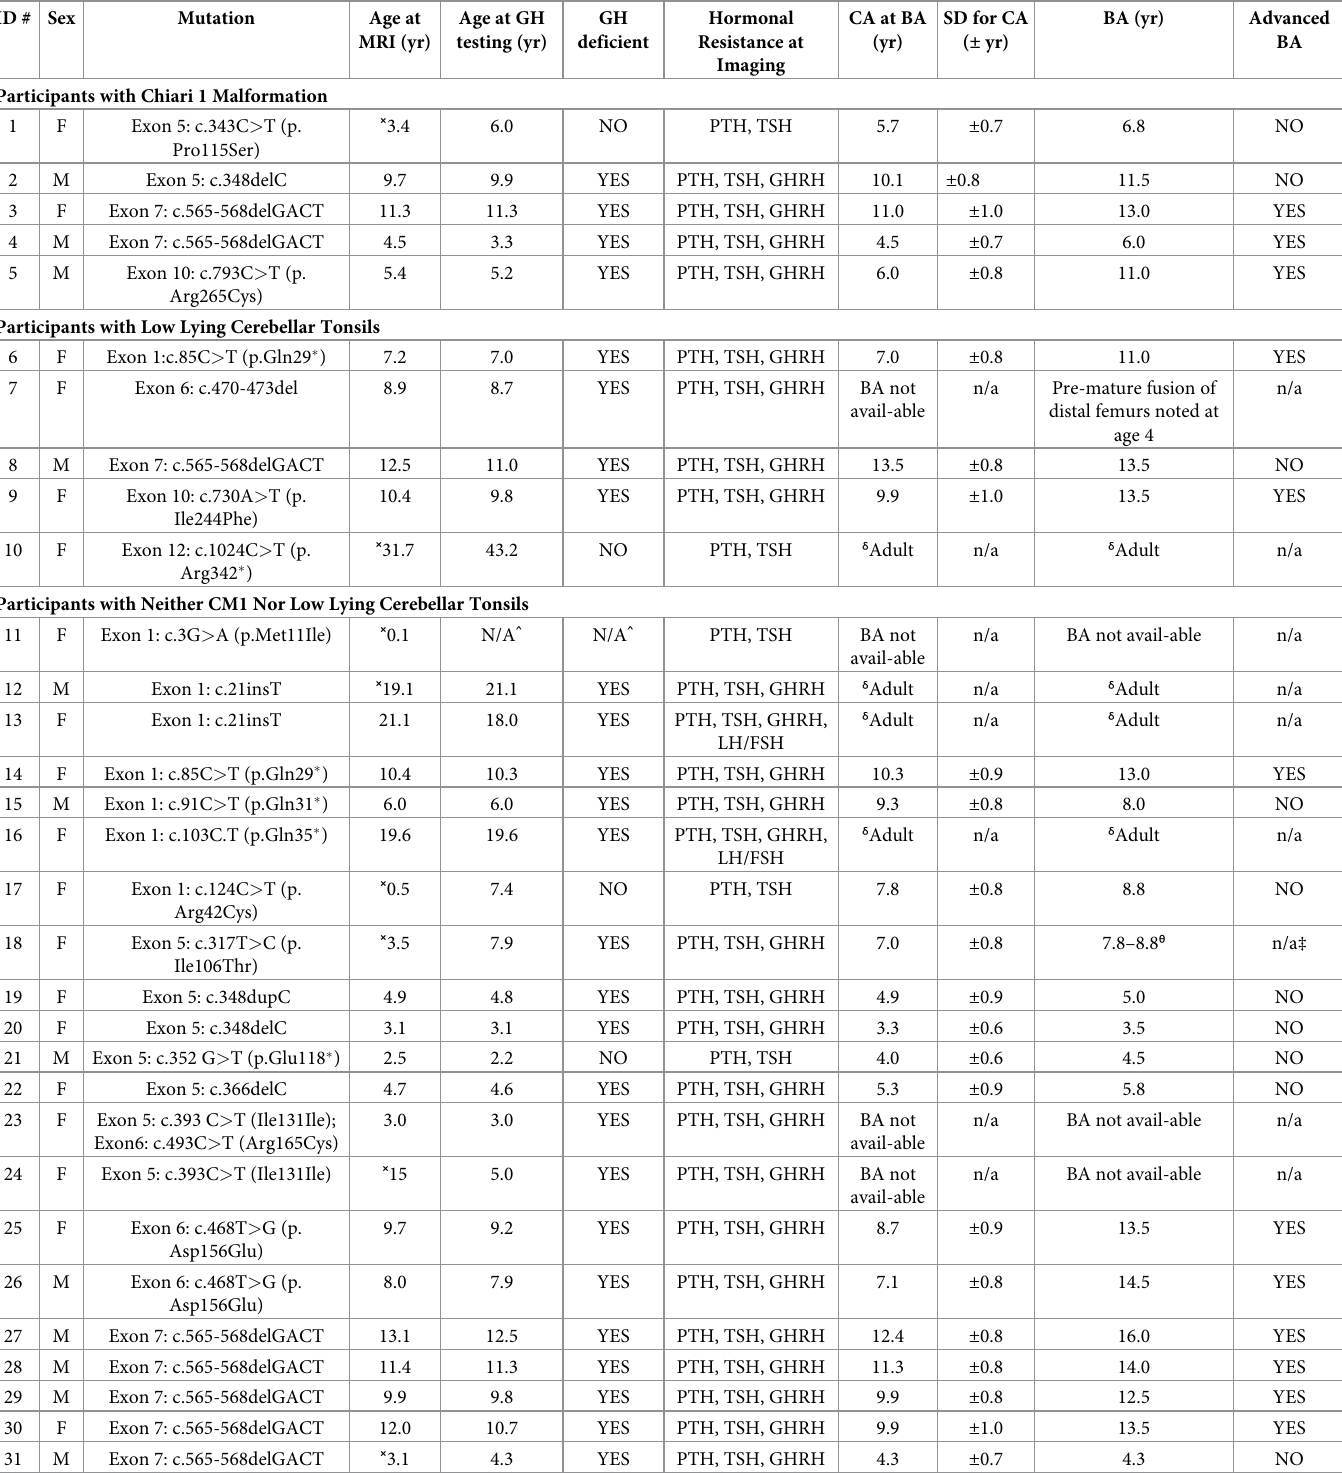
Table 1. Characteristics of mutation-confirmed PHP1A cohort. ID # Sex Mutation Age at